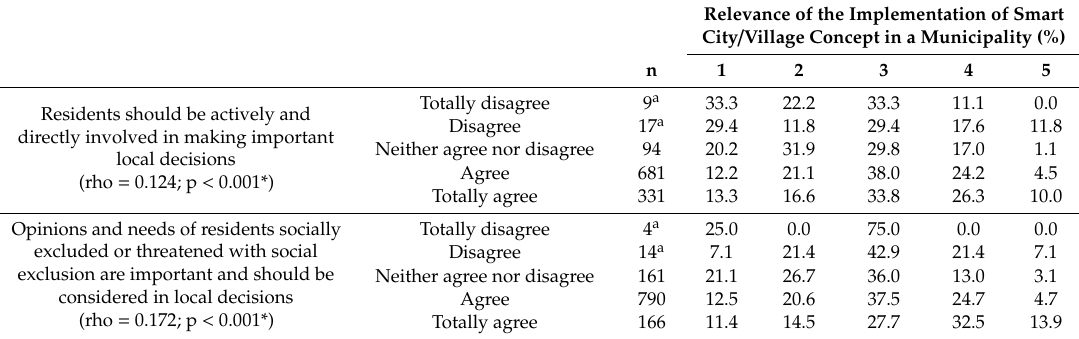
Table 5. Perception of residents’ involvement in local decision making and the relevance of the implementation of smart city / village concept (in